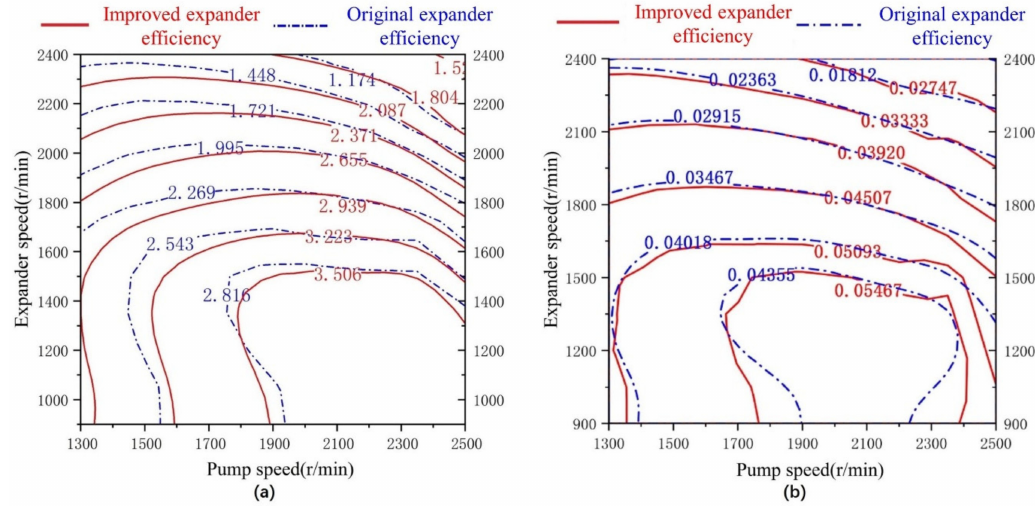
Figure 7. Influence of the expander e ffi ciency: ( a ) The net power and ( b ) the thermal e ffi